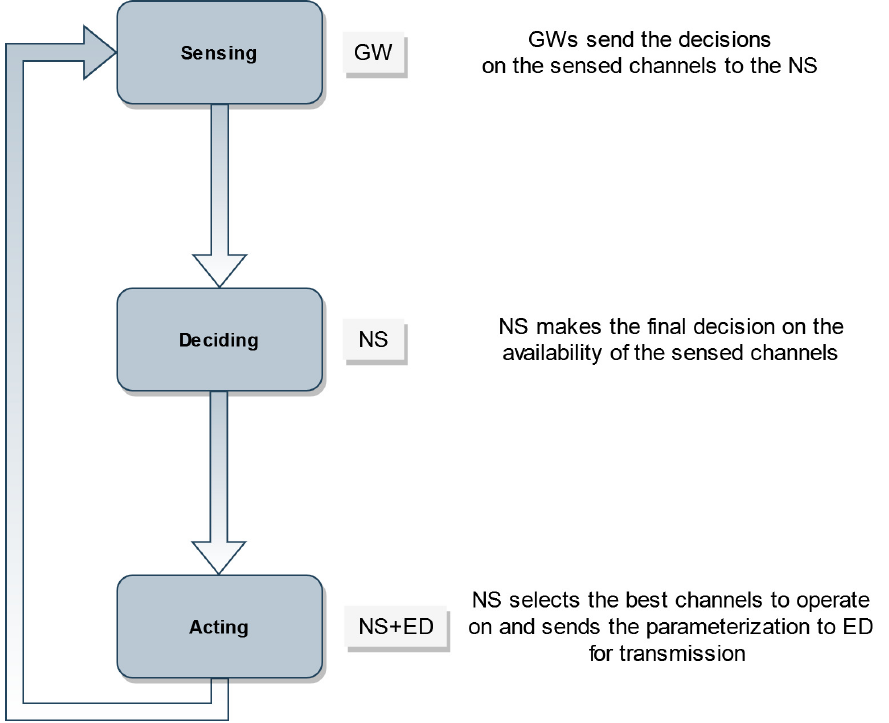
Figure 4. Cognitive Radio Cycle managed by